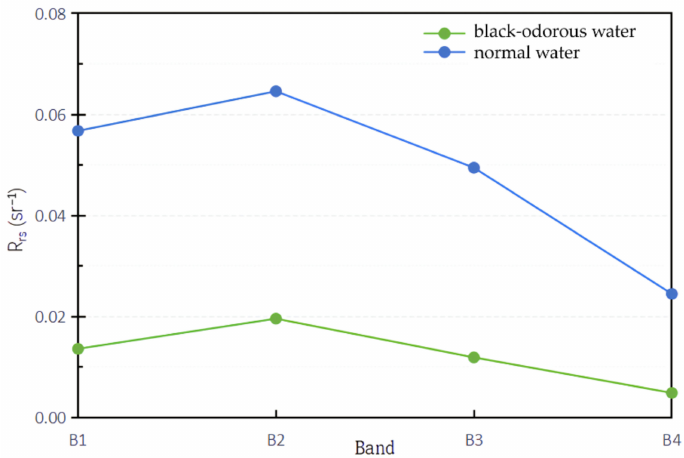
Figure 5. GF-2 simulation comparison of the mean reflectance of black-odorous water and general